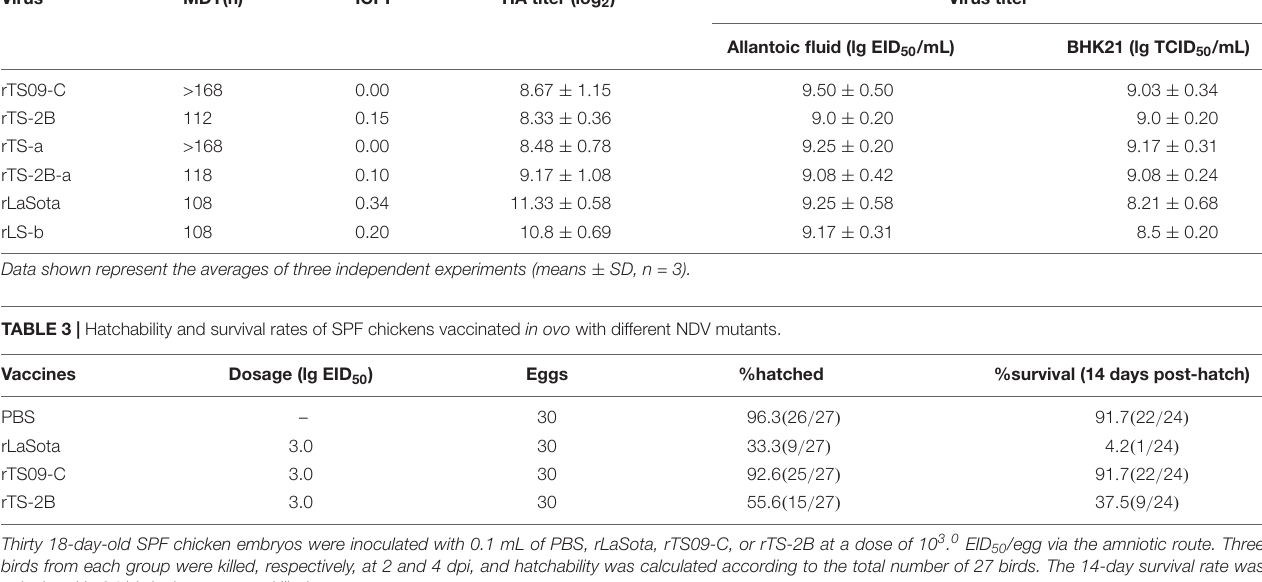
TABLE 2 | Pathogenicity and growth titer of different NDV mutants. Virus MDT(h)